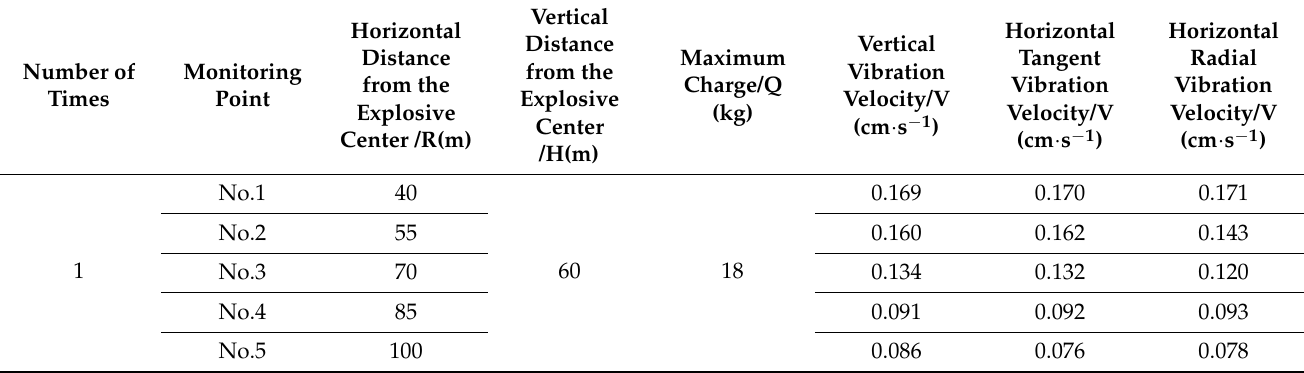
Table 2. The results of blast vibration